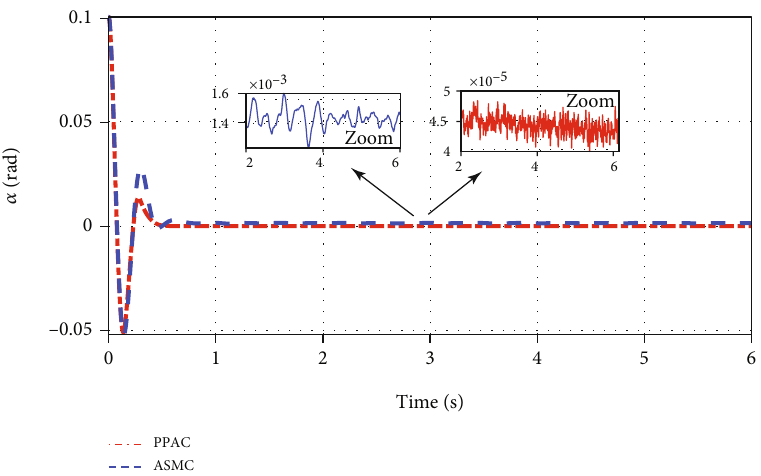
Figure 12: α responses of the closed-loop system with Case 2.